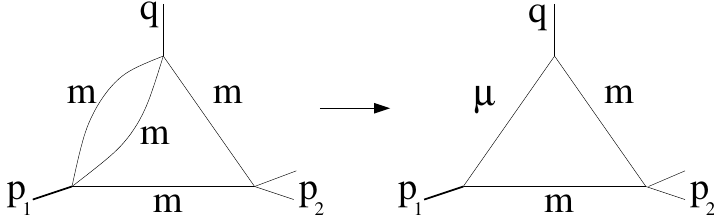
Figure 10. The triangle-diagram contribution to the K → 3 π amplitude may be reduced to the integral over µ 2 of the diagram F